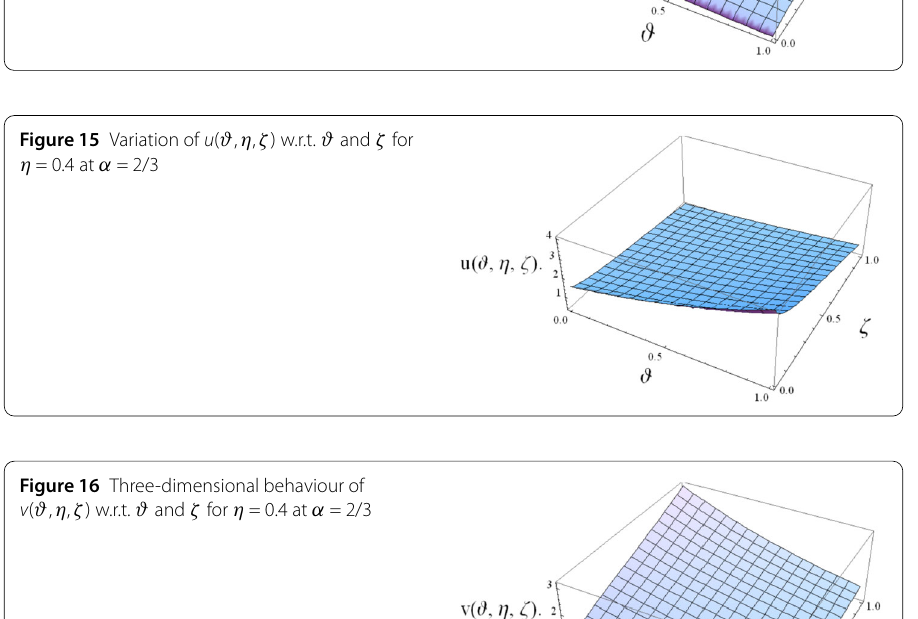
Figure 14 Three-dimensional behaviour of w ( ϑ , η , ζ ) w.r.t. ϑ and ζ for η = 0.4 at α = 1/3